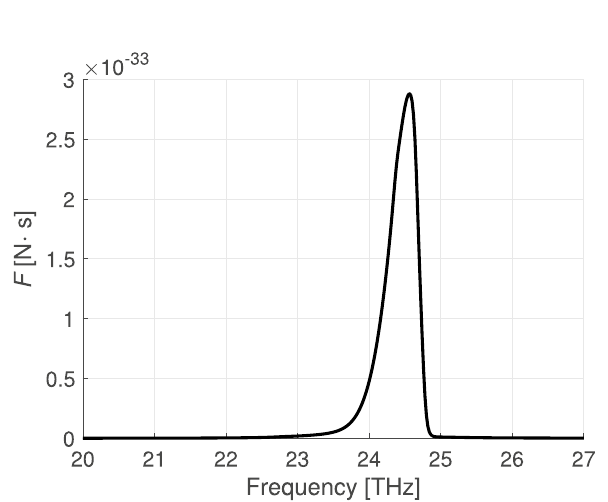
) (black solid line), Im( ǫ ⊥